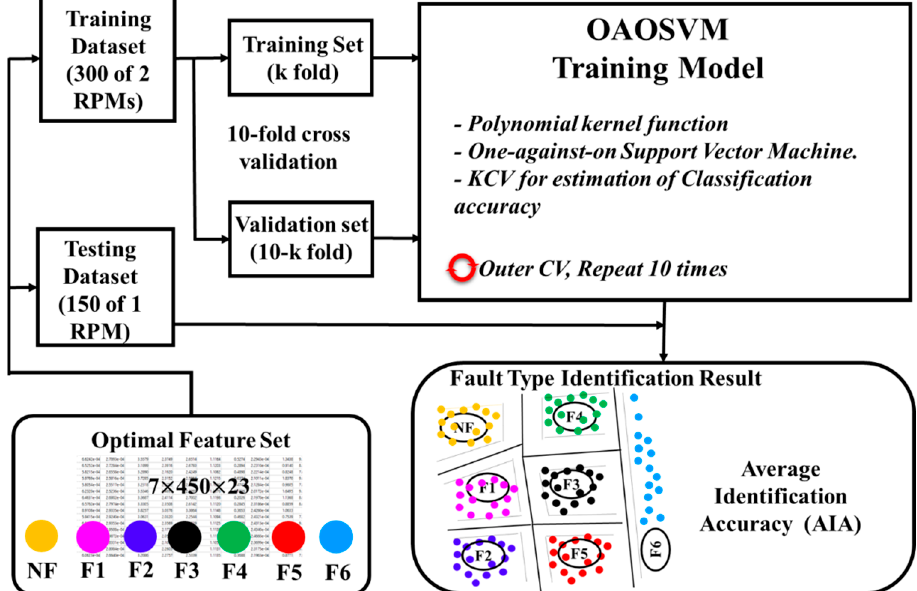
Figure 10. The learning model architecture using the one-against-one SVM.